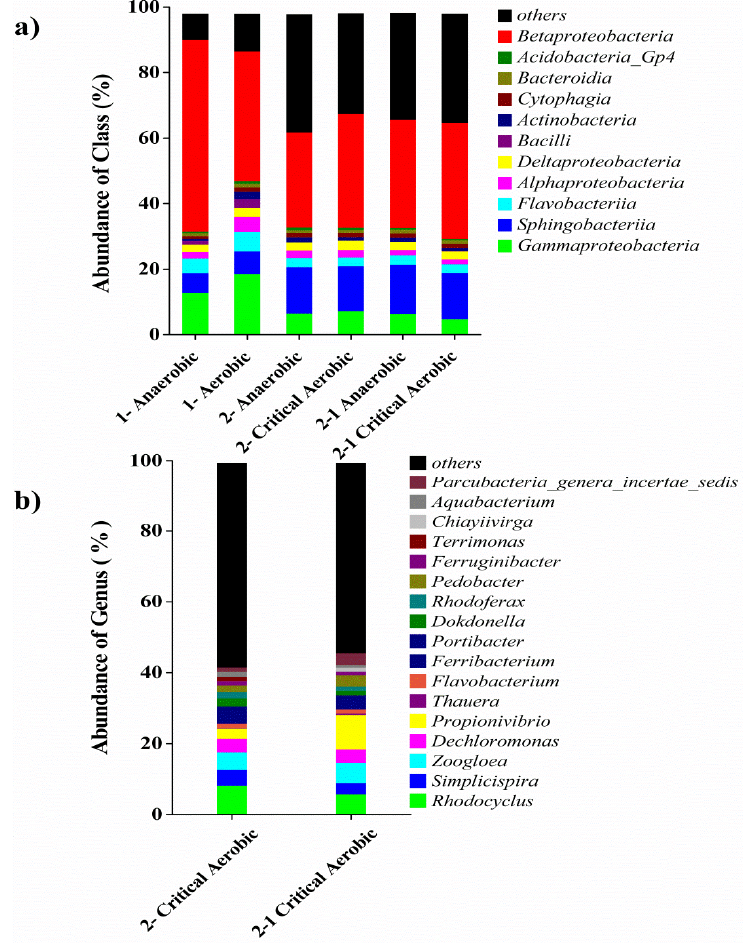
Figure 5. The results of the metagenomics analysis from the ( a ) class and ( b ) genus